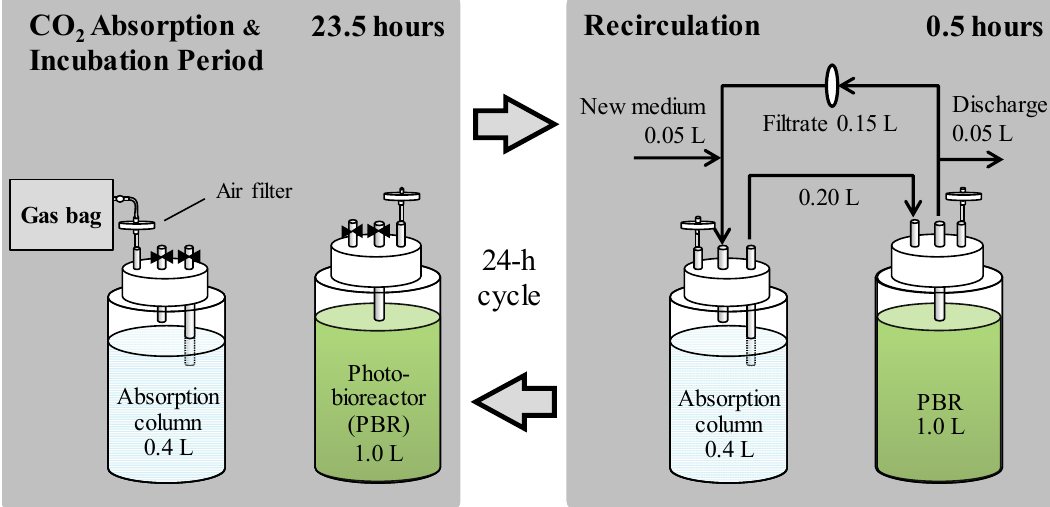
Figure 1. Experimental set-up of the semi-continuous two-phase CO 2 recovery process. After 23.5 hours of CO 2 absorption and algal incubation period, the medium was partially recirculated between the two reactors. After recirculation, the headspace of the absorption column was replaced with CO 2 containing gas (Table 1) and a newly filled gas bag was attached.